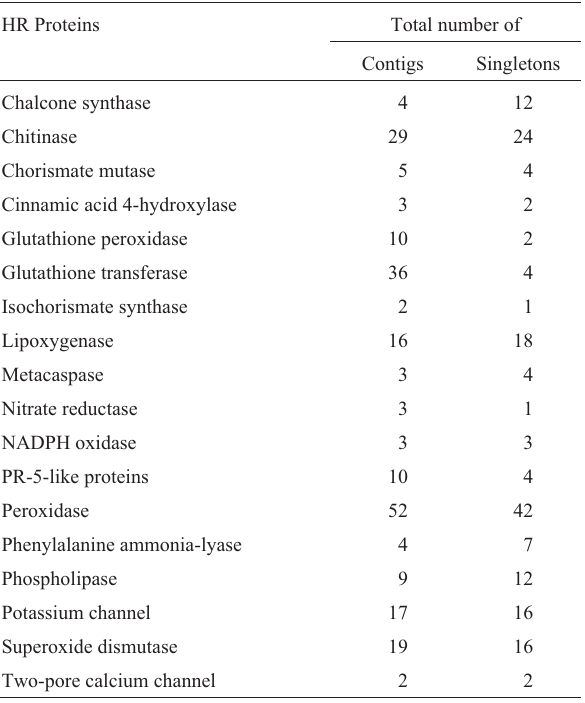
Table 1 - Classes of HR proteins identified in CitEST